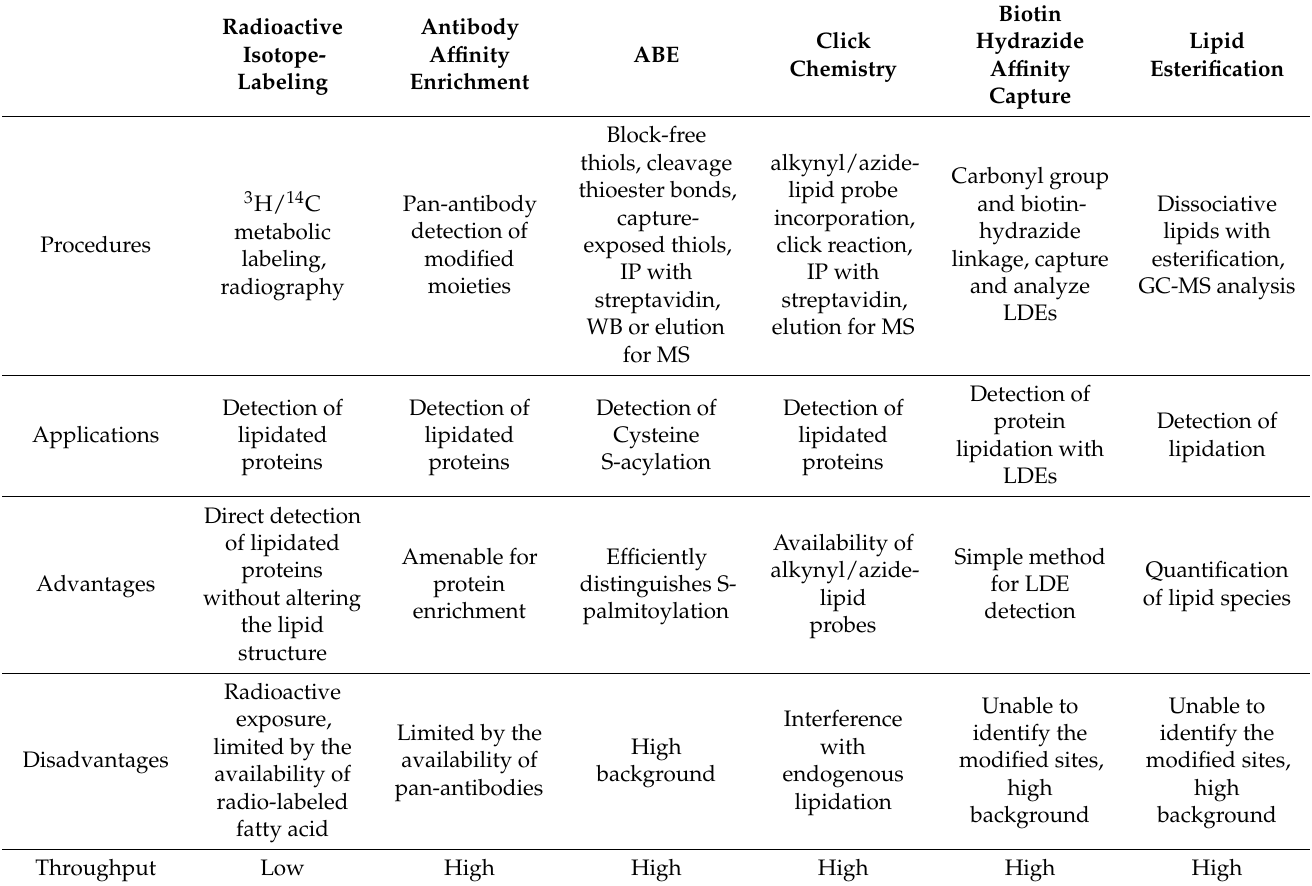
Table 2. Well-established enrichment methods to assess for protein